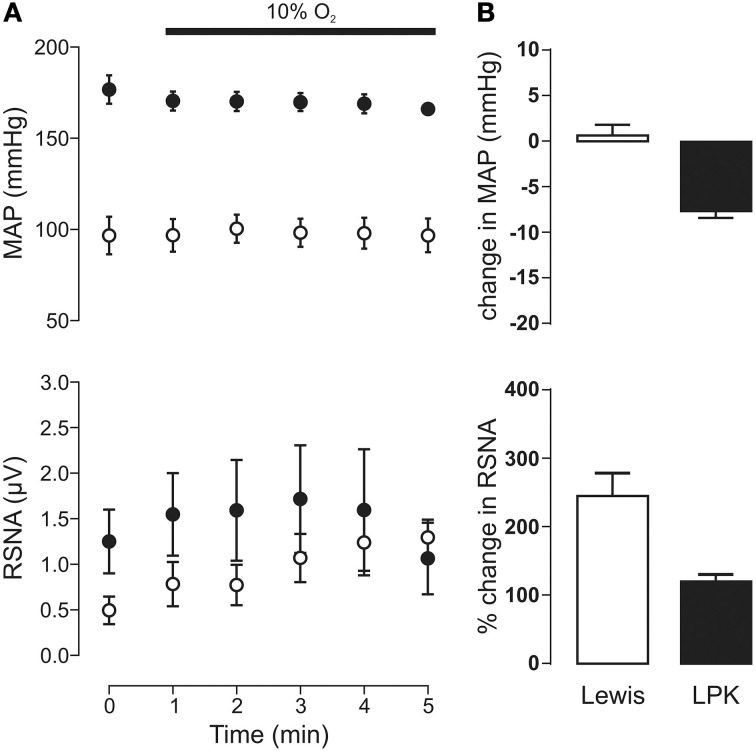
Mean arterial pressure (MAP) and renal sympathetic nerve activity (RSNA) responses to peripheral chemoreflex activation in Lewis and Lewis Polycystic Kidney (LPK) rats. (A) Data points are 1-min averages of MAP and RSNA measured for 1 min before (time zero) and 5 min during a hypoxic challenge (10% O2). Results are expressed as mean ± SEM. Minimum n/group = 4. (B) Average change in MAP and RSNA during the challenge. Results are expressed as mean ± SEM.